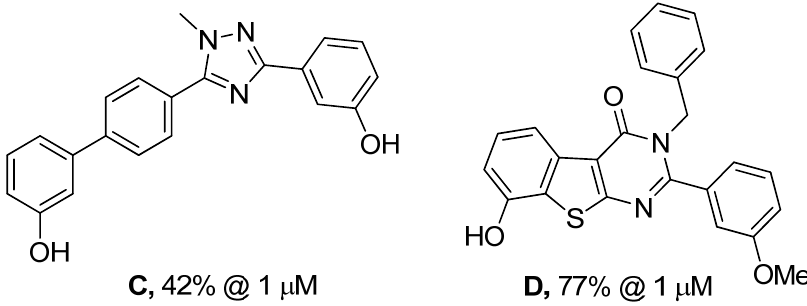
Figure 5. Described analogues of 3b/3d with rigidified amide bond